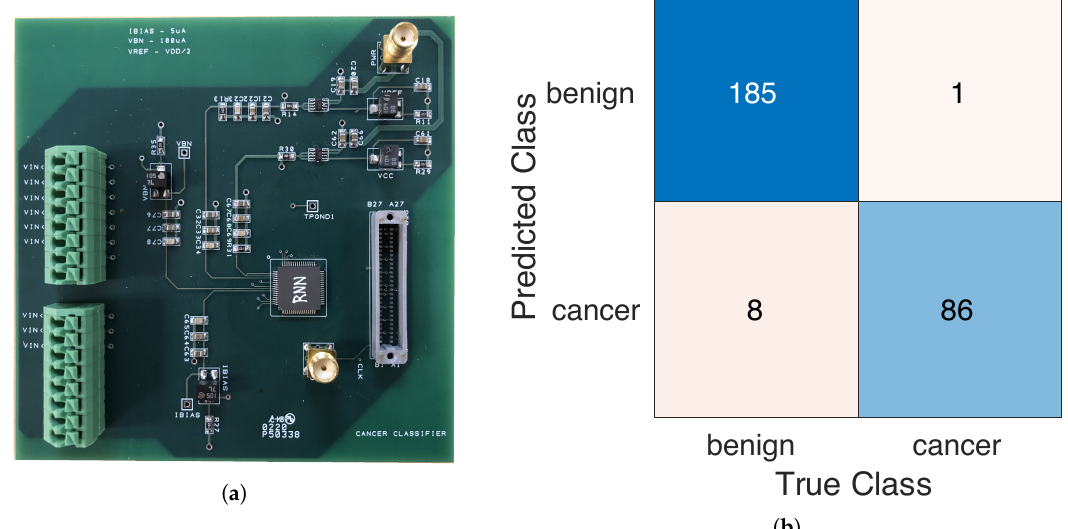
Figure 9. ( a ) PCB for validating proposed classifier ( b ) Measured confusion